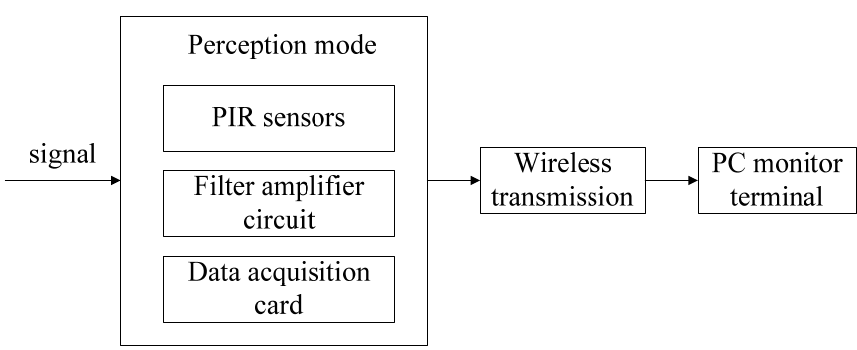
Figure 6 . Data acquisition flow